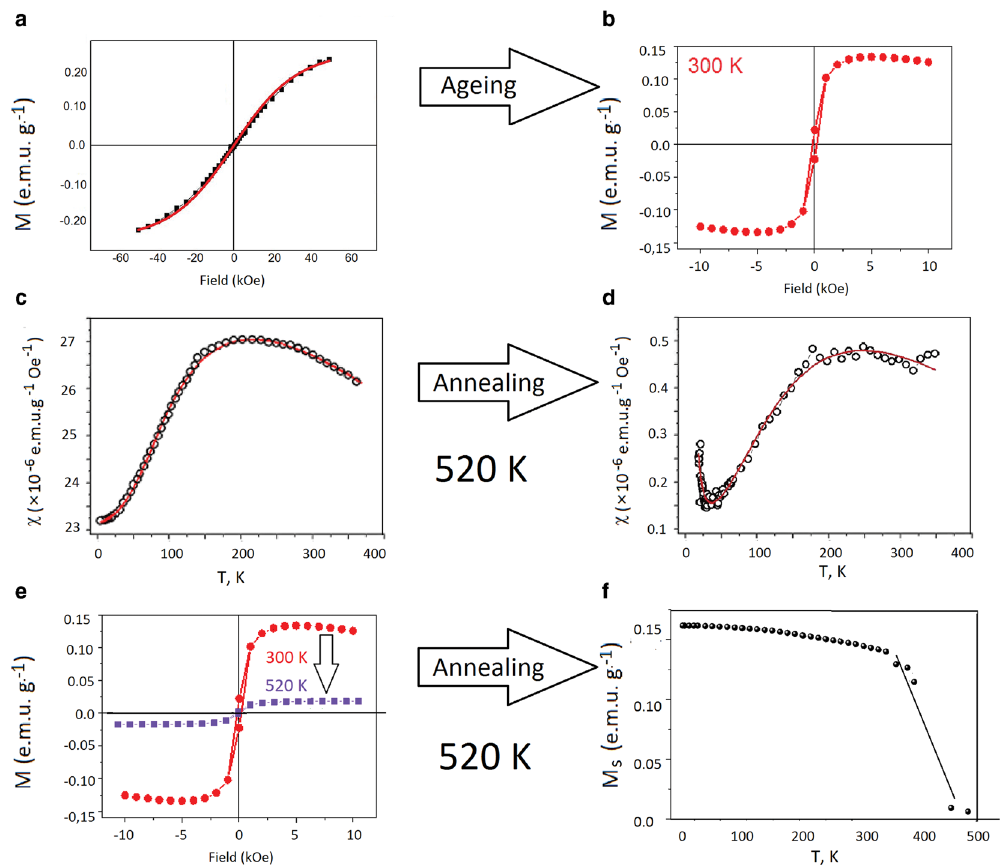
Figure 3. Evolution of the ferromagnetic properties of the Tabby graphene C 2 F x ( x < 1) upon ageing and annealing: ( a ) magnetic moment M as a function of a magnetic field H ; the symbols are the measurements and the solid curve fits the Brillouin function with S = ½ and g = 2; ( b ) M( H ) dependence of the same sample after 1 year of ageing at room temperature. The temperature dependences of the magnetic susceptibility of the aged sample; ( c ) the same sample after short-term heating to the fluorine detachment temperature 520 K ( d ). M( H ) dependence of an aged sample and the same sample after short-term heating to 520 K ( e ). Temperature dependence of the saturation magnetization M s for the Tabby graphene; the sharp decrease of M s around 400 K is due to the beginning of thermal irreversible destruction of the sample ( f